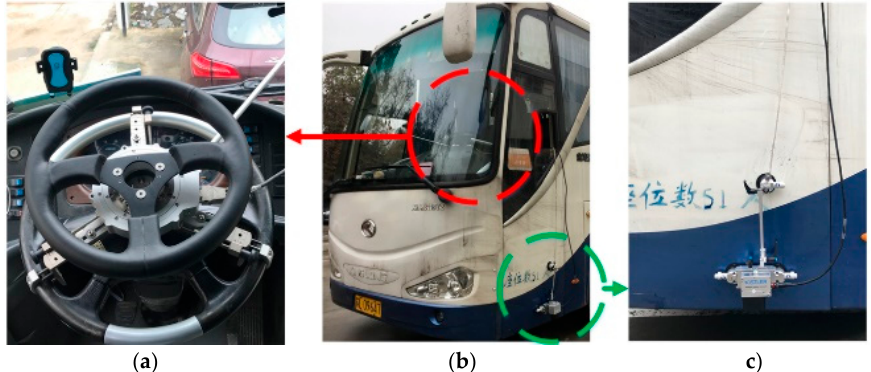
Figure 4. The designed test routes.